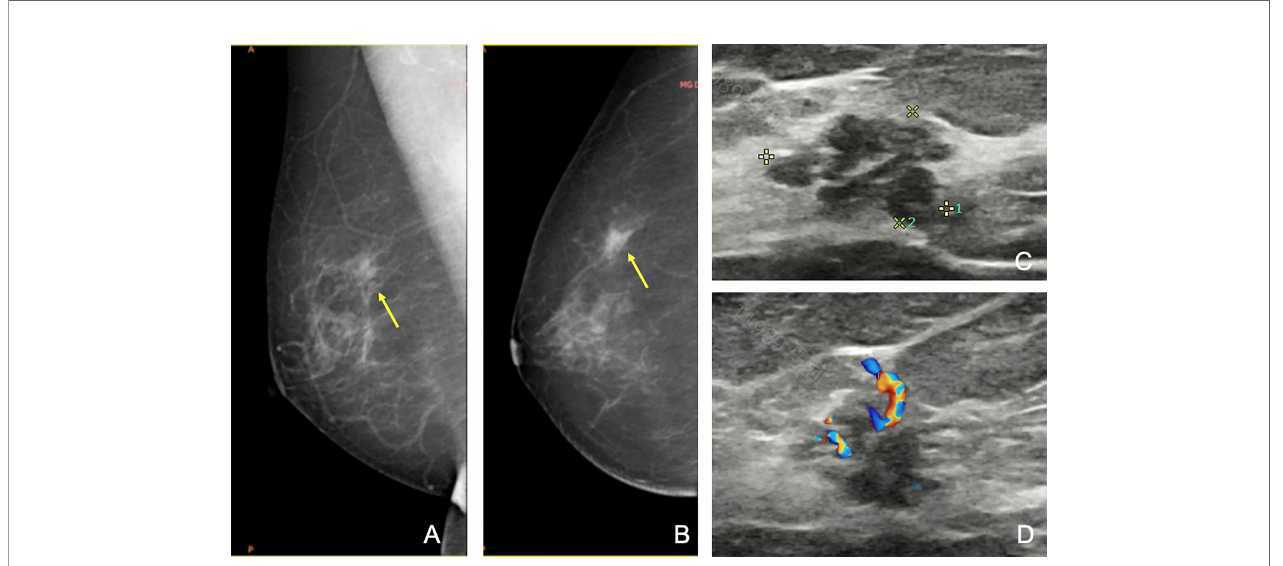
FIGURE 2 | A 69-year-old woman was referred to our hospital for a category 5 mass on the left breast, and the second-look US found a new 4a mass on the right breast, which was missed at the initial assessment. Craniocaudal (A) and mediolateral oblique (B) mammograms of the right breast showing focal asymmetric dense tissue (arrows). However, since the fi rst ultrasound failed to fi nd any lesions, this lesion was unreported. (C, D) Second US showing a heterogenous lesion with micro-lobulated margin and linear vascularity. After reviewing the mammography, this lesion was re-categorized as 4a. Subsequent biopsy con fi rmed ductal in situ carcinoma. The patient fi nally received breast conservative surgery on both sides.